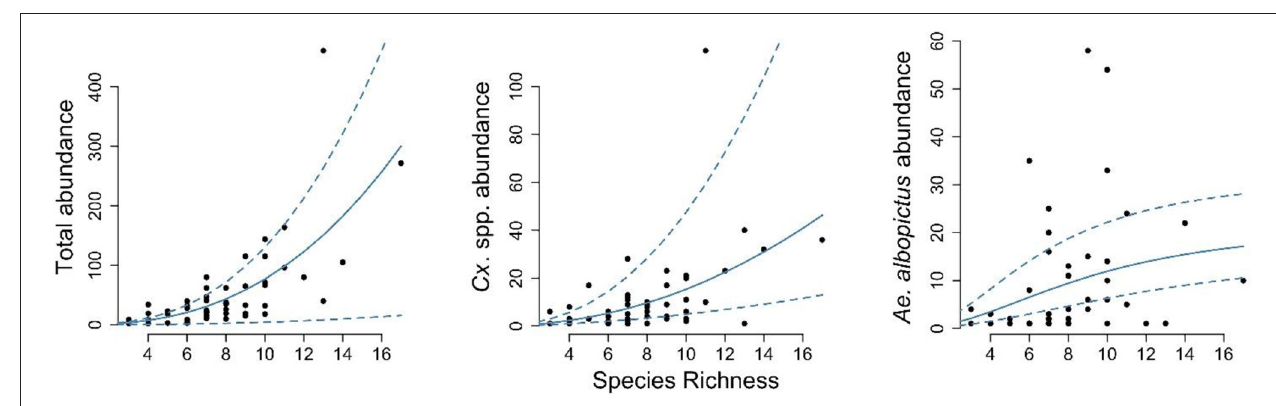
FIGURE 3 | The relation between mosquito species richness and mosquito abundance. For each sampling site, the species richness over the entire season is compared the total mosquito abundance (left panel), the abundance of Culex pipiens complex (middle panel), and the abundance of Aedes albopictus (right panel). The solid blue lines represent the best fit, estimated using maximum likelihood, and the dashed lines the associated 95% confidence interval.